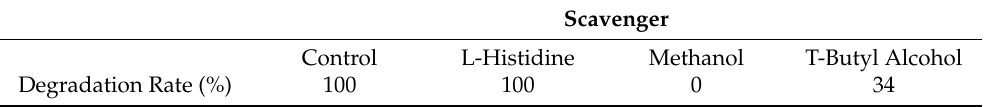
Table 1. Impact of different scavengers on the performance of SZP ([BPA] 0 = 0.02 mM, flow rate = 5